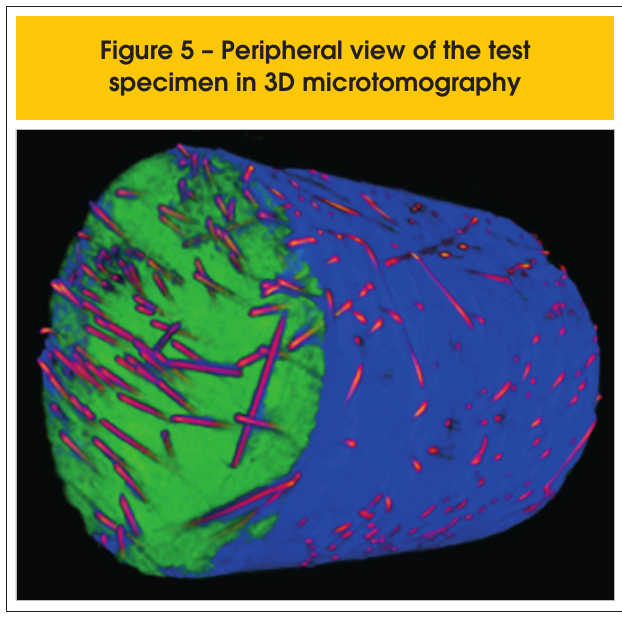
Figure 5 – Peripheral view of the test specimen in 3D